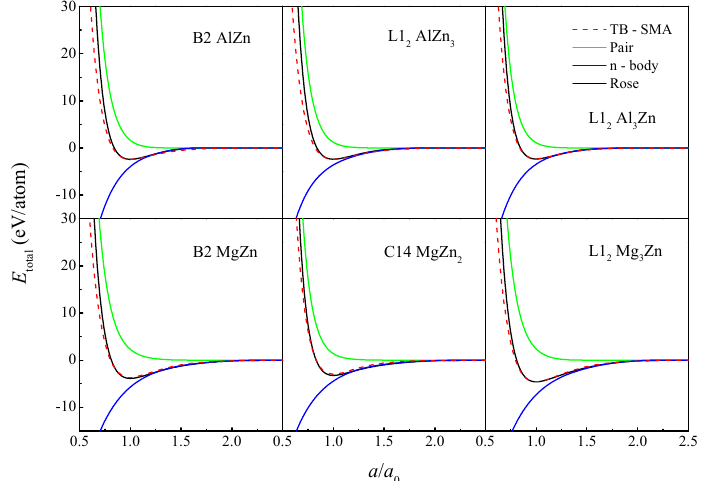
Figure 1. The total energies (red dash line), pair terms (green solid line), and n-body parts (blue solid line) variation with lattice constants calculated using the rose equation (black solid line), and the TB-SMA potential for compounds of AlZn, AlZn 3 , Al 3 Zn, MgZn, MgZn 2 , and Mg 3 Zn.